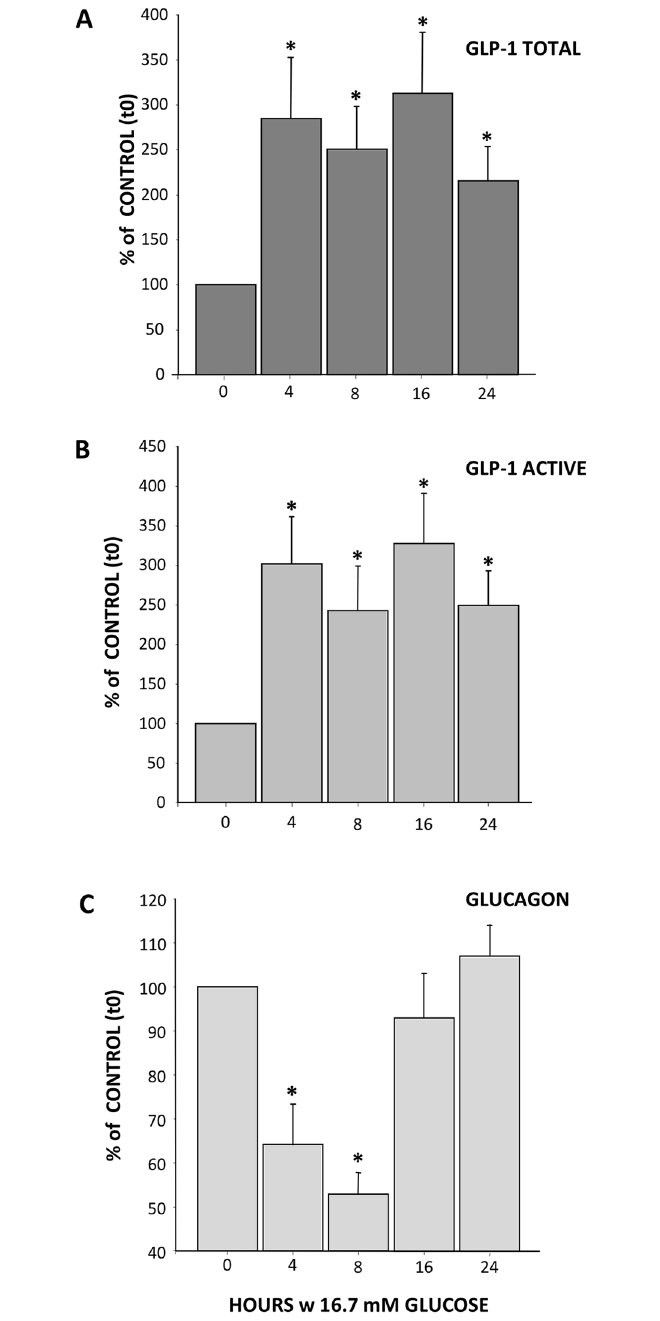
Fig 2. Effect of high glucose on glucagon and GLP-1 secretion. Cells were incubatedwith 16.7mM glucoseand hormone concentration in the medium determinedby ELISA method. Panel A: Total GLP-1 secretion; Panel B: Active GLP-1 secretionand Panel C: Glucagonsecretion. Results are % of control and expressedas MEAN ± SEM, n = 4. * p < 0.05comparedto control.